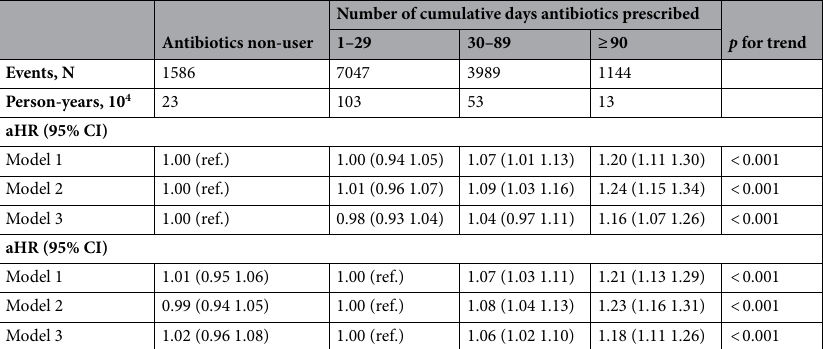
Table 2. Hazard ratios for diabetes by number of cumulative days antibiotics prescribed. aHR adjusted hazard ratio, CI confidence interval, ref. reference. Model 1 Adjusted for age, sex, and body mass index. Model 2 Adjusted for Model 1 plus smoking status, days with alcohol drinking per week, physical activity, household income, and residence. Model 3 Adjusted for Model 2 plus family history of diabetes, Charlson comorbidity index, fasting blood sugar, total cholesterol, and acid suppressants